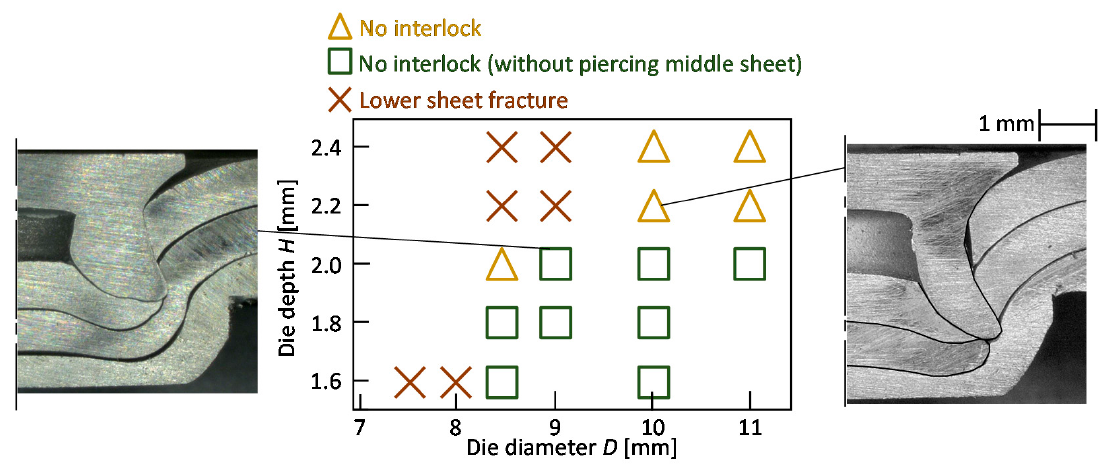
Figure 10. Joining range for L = 5 mm and without adhesive.